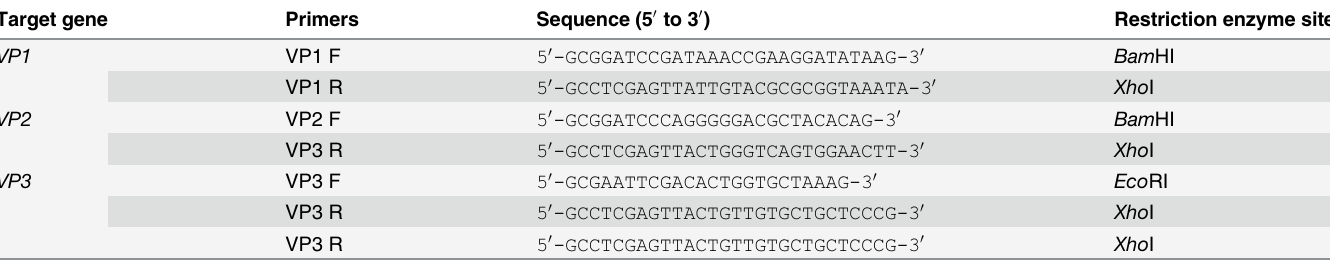
Table 1. Synthetic oligonucleotides for amplification of VP1 , VP2 , and VP3 genes. Target